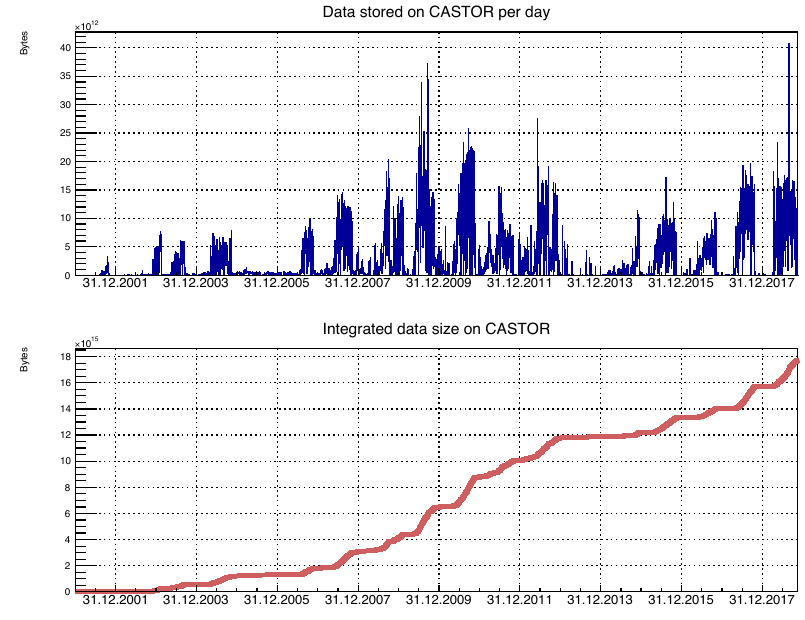
Fig. 1. COMPASS data on Castor: data stored per day (top) and integrated data size